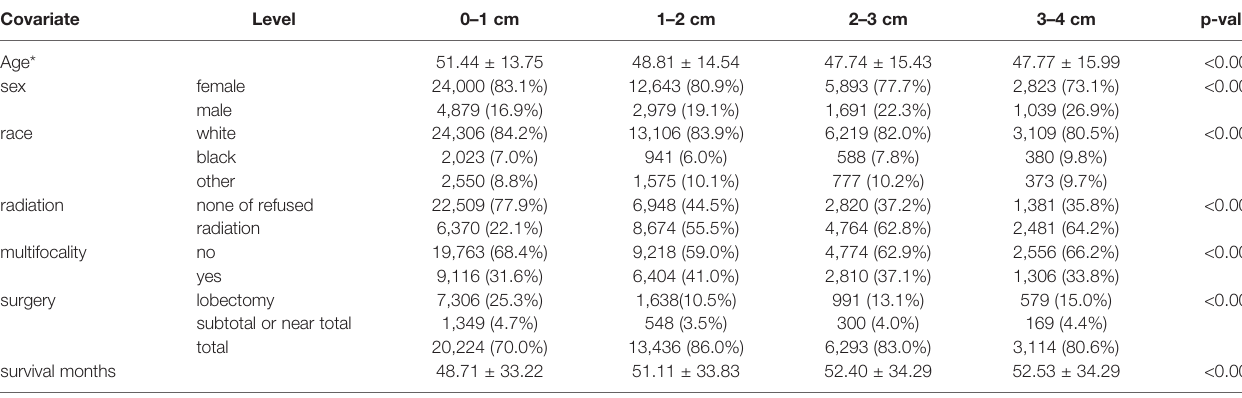
TABLE 1 | Charectaristic for patients with EXE ( − ), N0, M0, tumor size 0 – 4 cm. Covariate